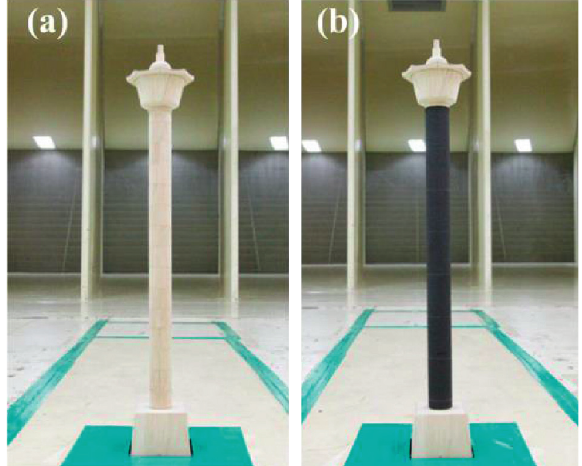
Figure 10: Wind tunnel models: (a) original model; (b) model with